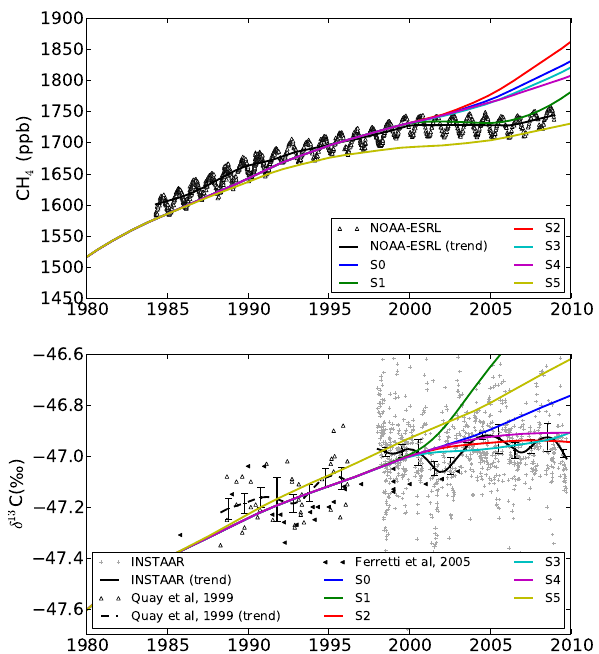
Fig. 3. Comparison between model results for the scenarios S0 to S5 and measurements at the station of Cape-Grim, Australia, for methane (top) and δ 13 C-CH 4 (bottom). Model results are shown as deseasonalized trends (2-yr smoothing). Error bars represent the uncertainty of the calculated trend (yearly RMSE divided by the number of